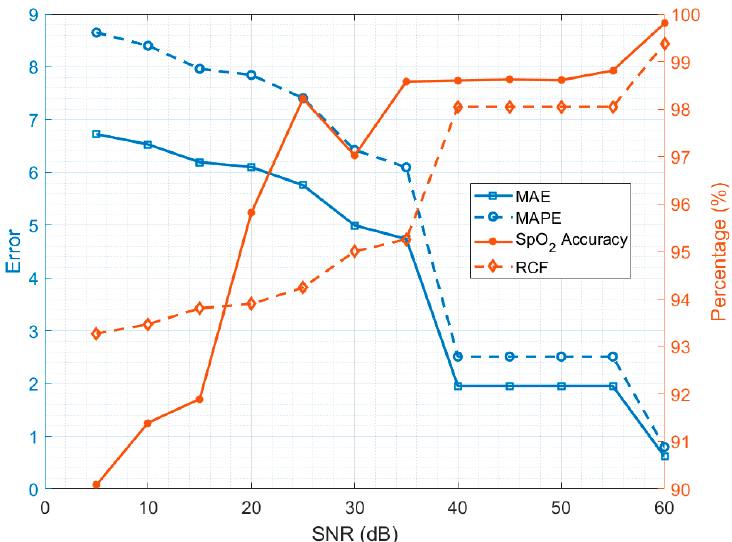
Figure 26. Proposed wearable PO device performance for different signal ‐ to ‐ noise ratio (SNR) values. MAE, mean absolute error; MAPE, mean absolute percentage error; RCF, reference closeness factor.